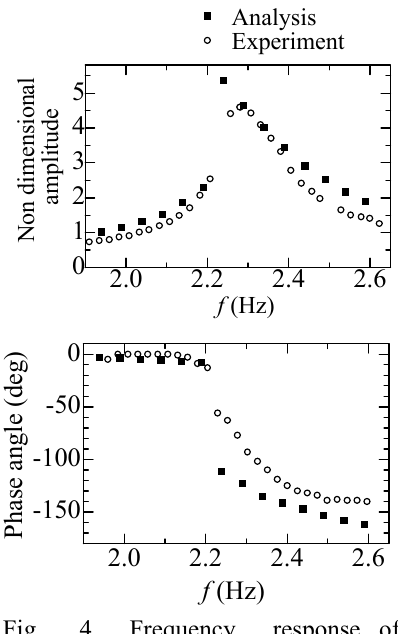
Fig. 4 Frequency response of non-dimensional wave amplitude normalized by the excitation amplitude and wave phase angle at the center of interface.